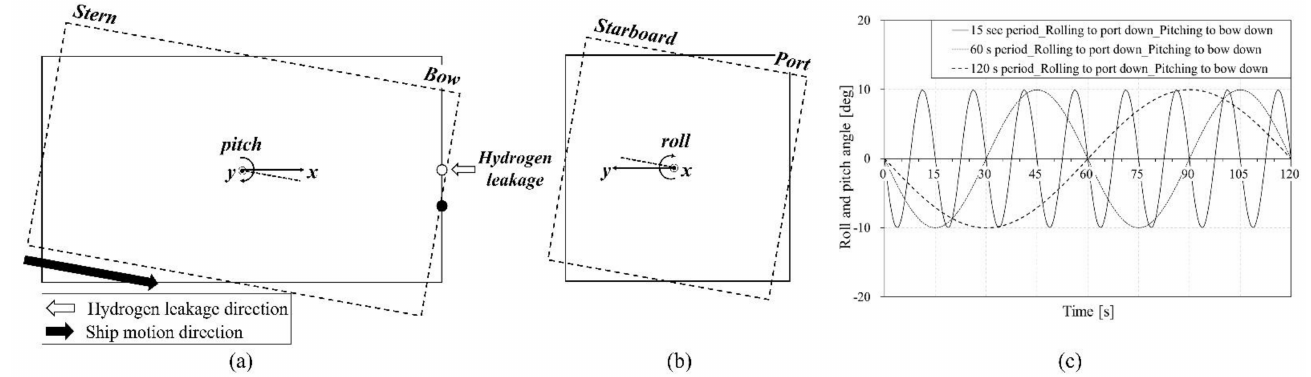
Figure 8. Plane view and ship motion period graph: ( a ) Pitching to bow down; ( b ) Rolling to port down; ( c ) Counterclockwise.